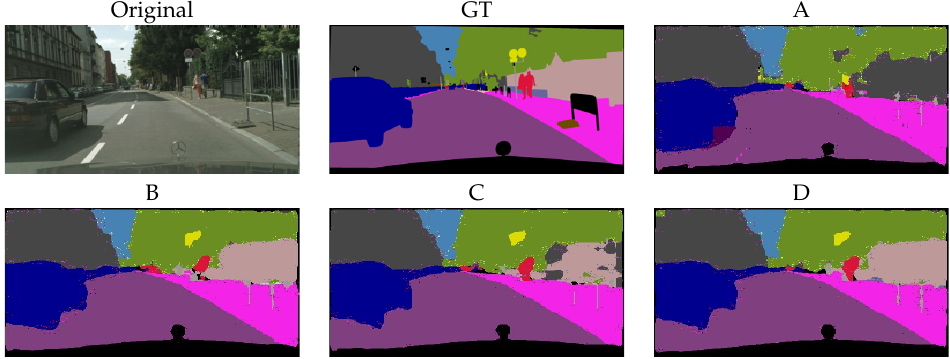
Figure 22. Comparison results of semantic segmentation in each Cityscapes